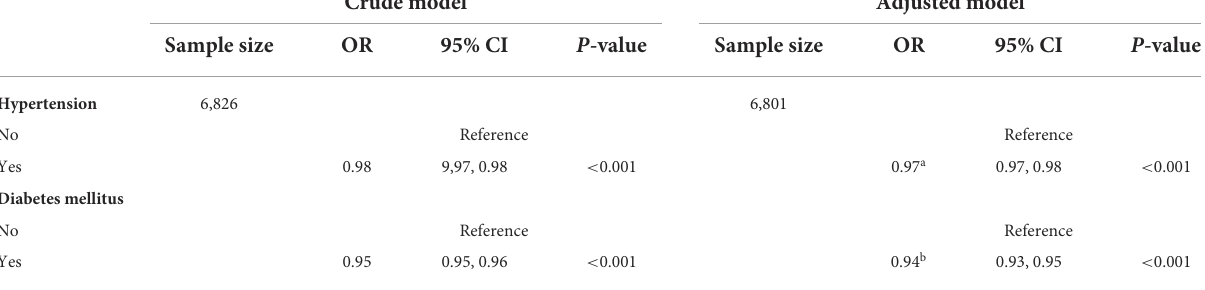
TABLE 3 Logistic regression analyses for the association between each score of DDS and cardiometabolic risk factors among older participants.